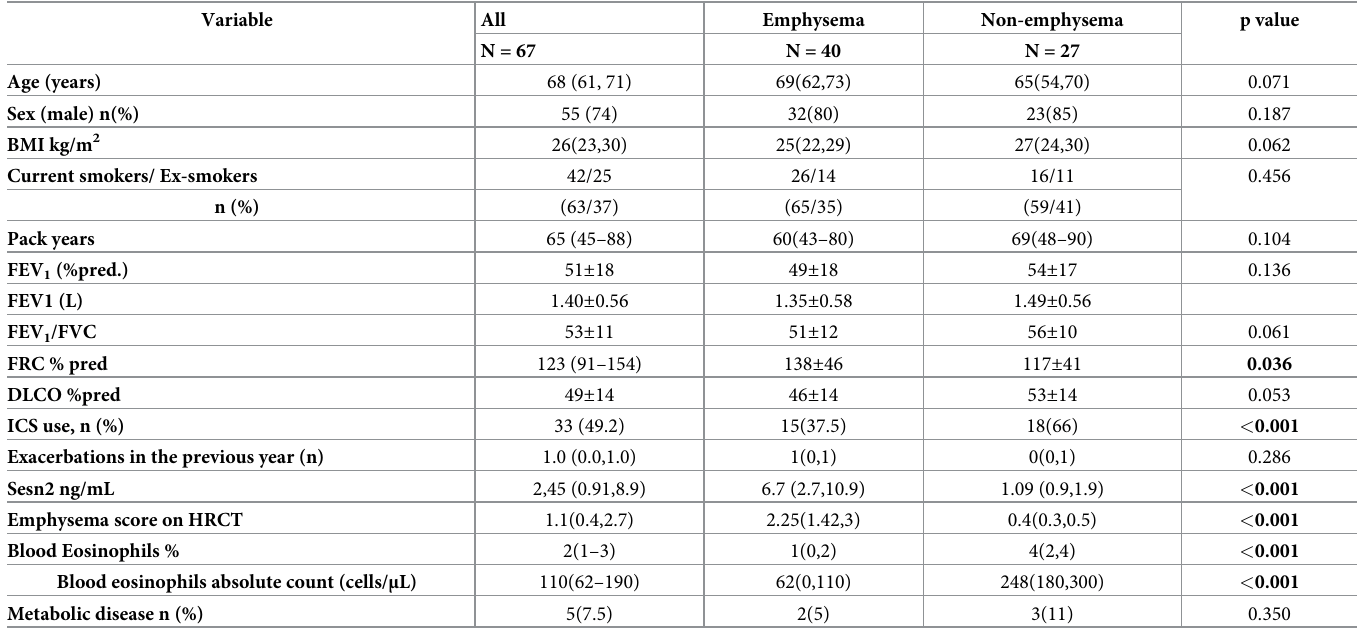
Table 1. Demographic, functional and inflammatory characteristics of the study participants (all and according to the presence of emphysema). Variable